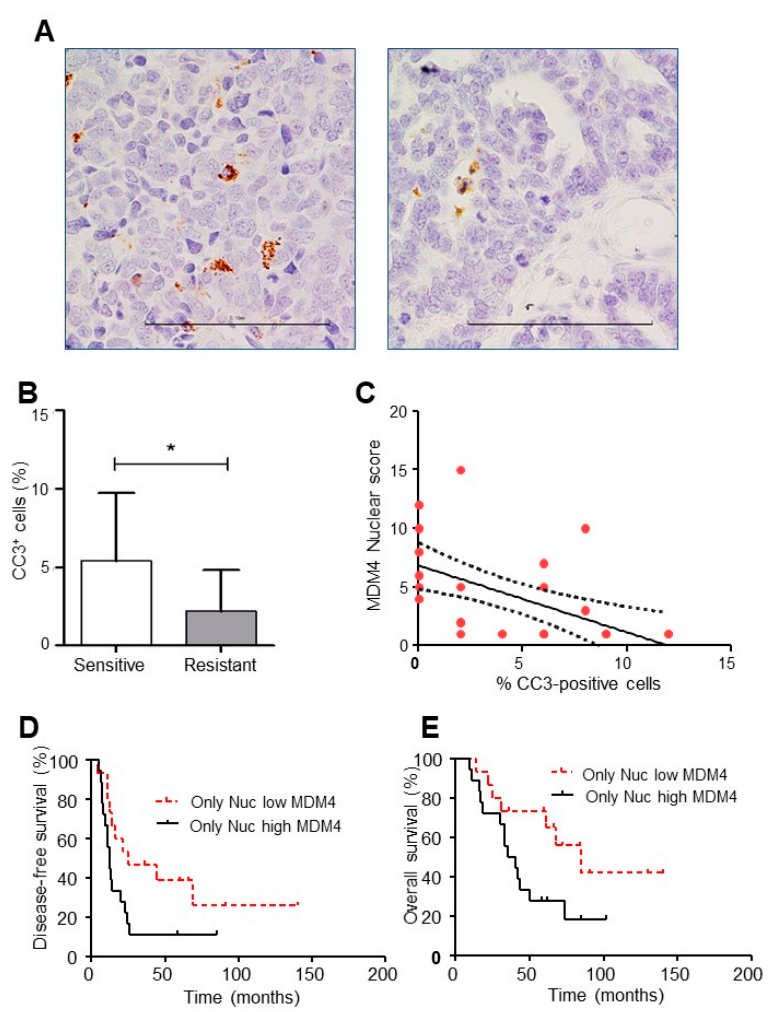
Figure 6. Nuclear MDM4 correlates with decreased cell death and DFS in HGSOC. ( A ) Representative pictures of cleaved caspase-3 staining (CC3) in HGSOC (left and right panels show high and low expression levels, respectively, scale bar 100 µ m). ( B ) CC3 expression in sensitive and resistant patients (mean ± SD, two-tailed unpaired t -test, n = 31, DF = 29, t = 2.230, * p = 0.034). ( C ), Correlation between CC3 and nuclear MDM4 in HGSOC (Spearman rank correlation, p < 0.0001, r = 0.7, 95% CI − 0.8 to 0.4). ( D , E ) Disease-free survival ( D ) and overall survival ( E ) of patients according to the expression of nuclear MDM4 in HGSOC. High expression of MDM4 in the nuclear compartment is associated with decreased disease-free survival and overall survival (Log-rank test ( D ) χ 2 = 4.172, df = 1 p = 0.041; ( E ) χ 2 = 3.670, df = 1 p = 0.055).